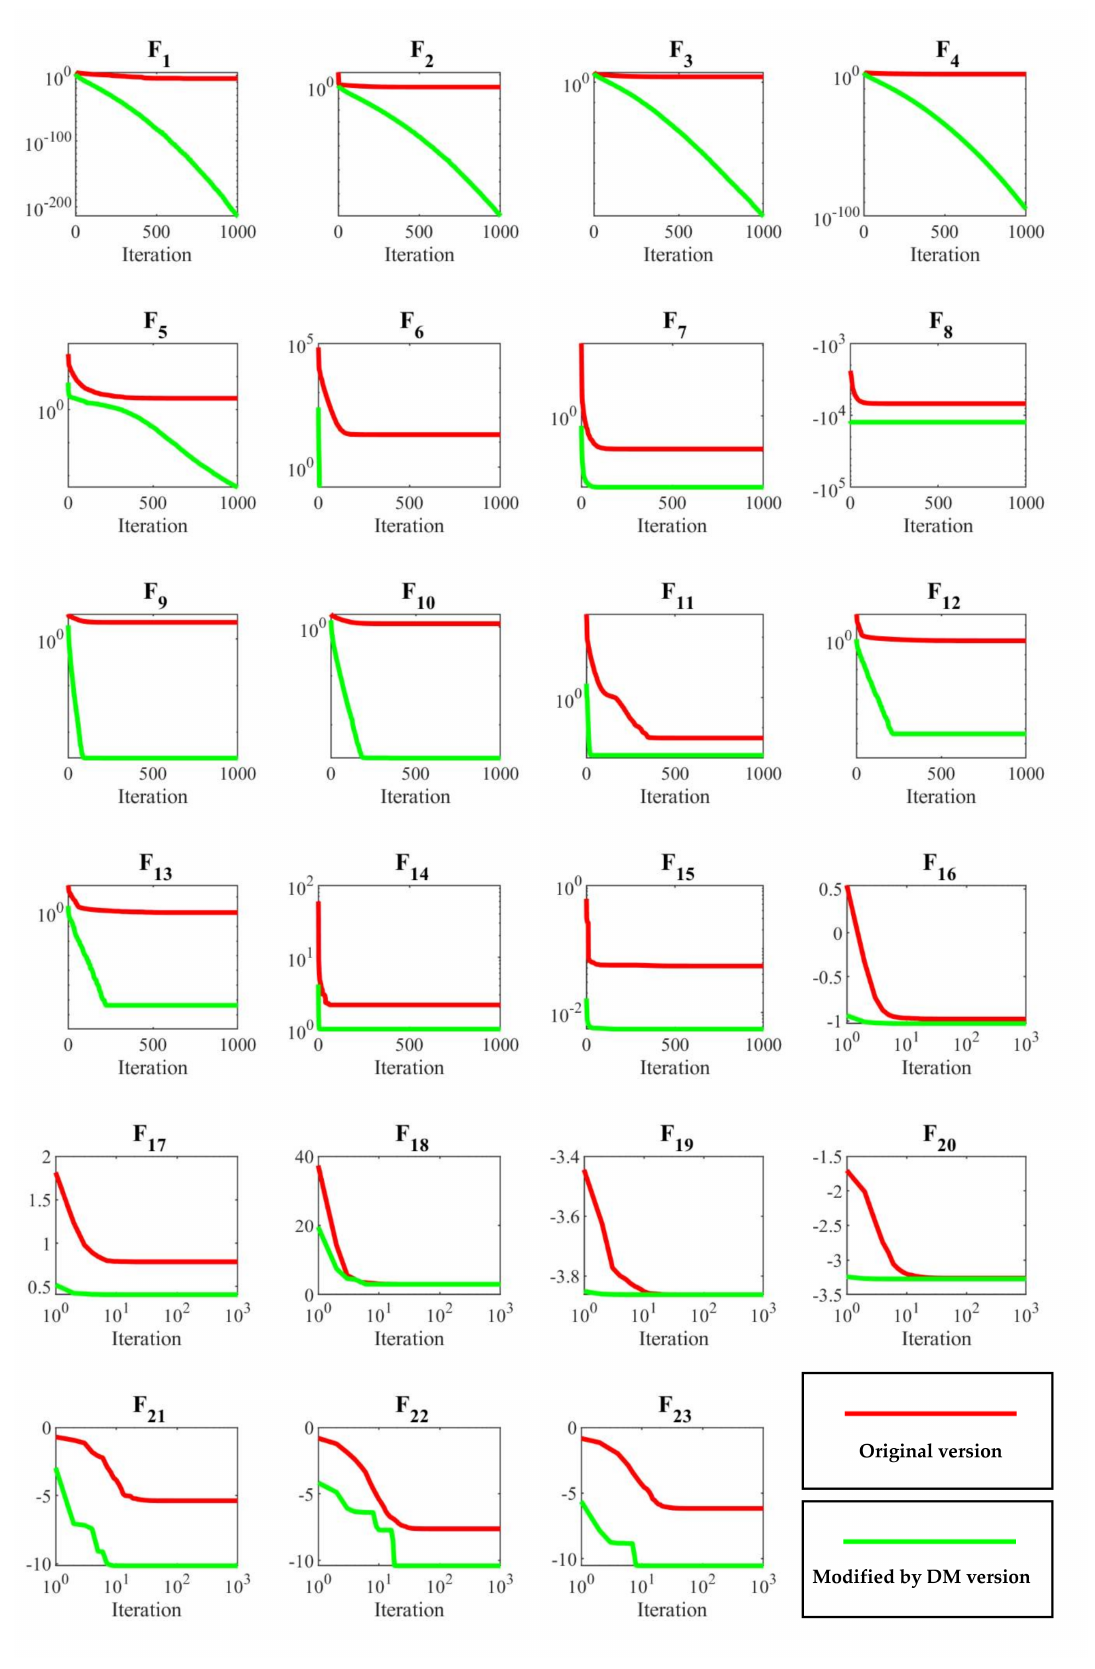
Figure 4. The convergence curves of PSO for original and “modified by DM”